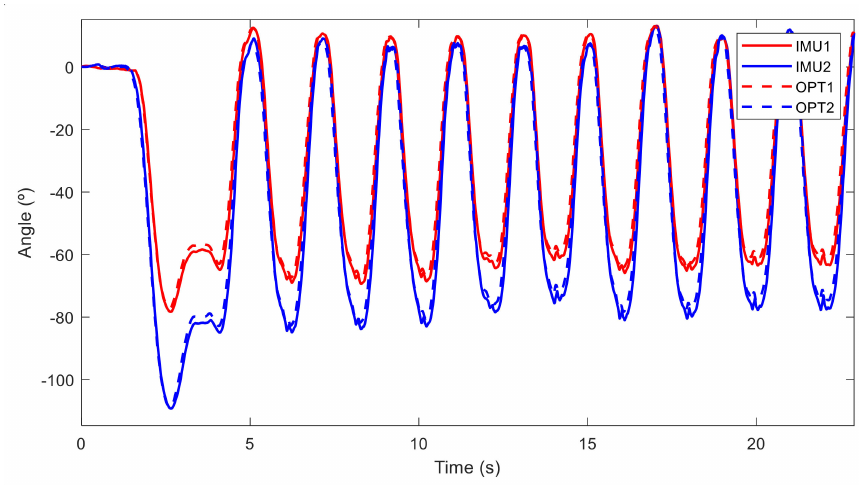
Figure 10. Angles measured by sensors in the sagittal plane from a woman with experience B performing deadlifts with a neutral spine position. IMU1 and IMU2 are the measurements from inertial sensor 1 (at L5) and sensor 2 (T8), respectively, and OPT1 and OPT2 are the measurements from optical motion system and markers situated at L5 and T8, respectively.